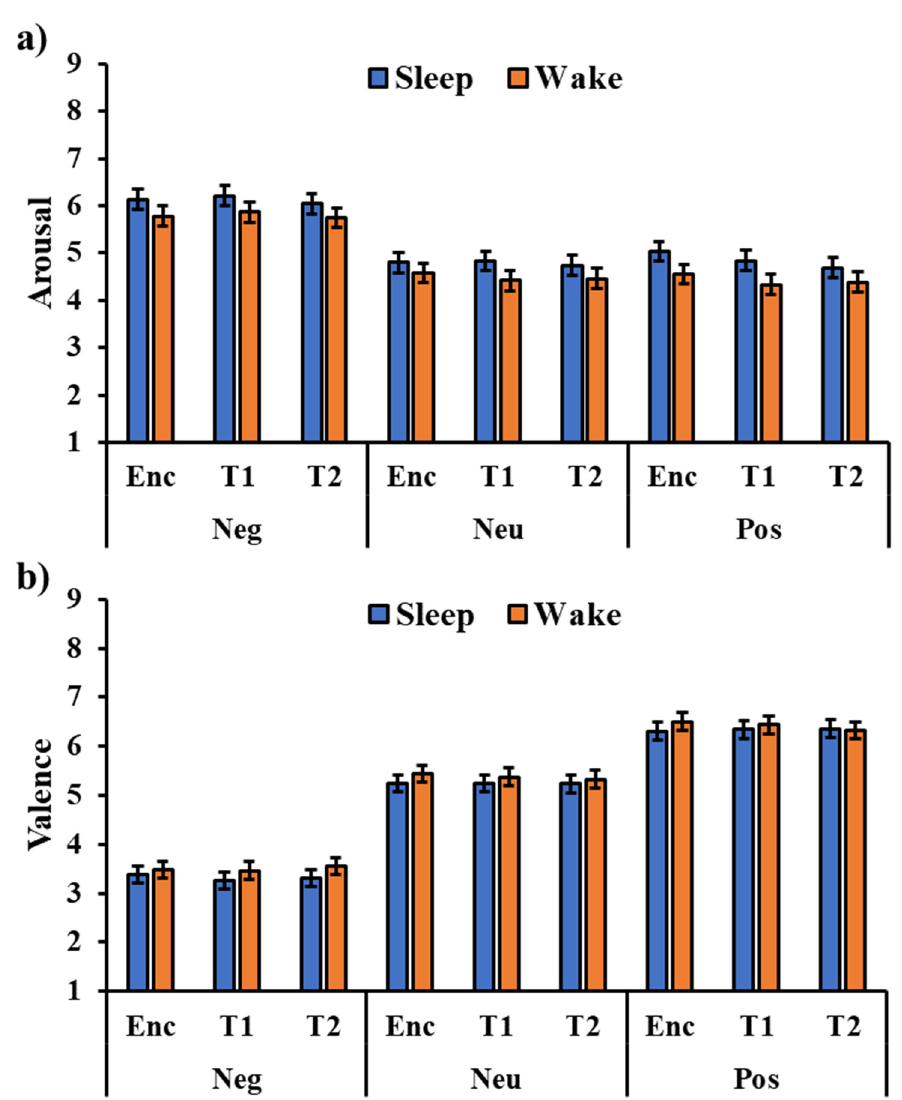
Figure 2. Arousal ( a ) and valence ( b ) ratings for the three types of images (Neg: Negative, Neu: Neutral, Pos: Positive) in the two groups in the encoding (Enc) and two testing sessions (T1, T2). The error bars represent the standard error of the means.